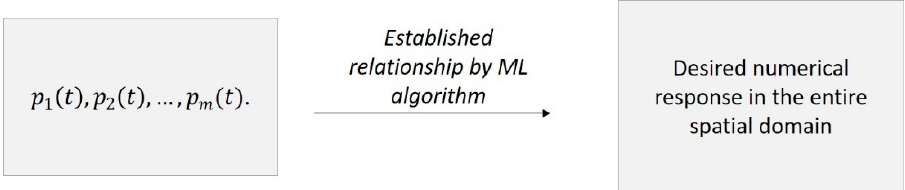
Figure 2. Schematic of ML training approach. Quantities p 1 ( t ) , p 2 ( t ) , . . . , p m ( t ) are evaluated in the finite element model, and the ML model is trained using these quantities as inputs.